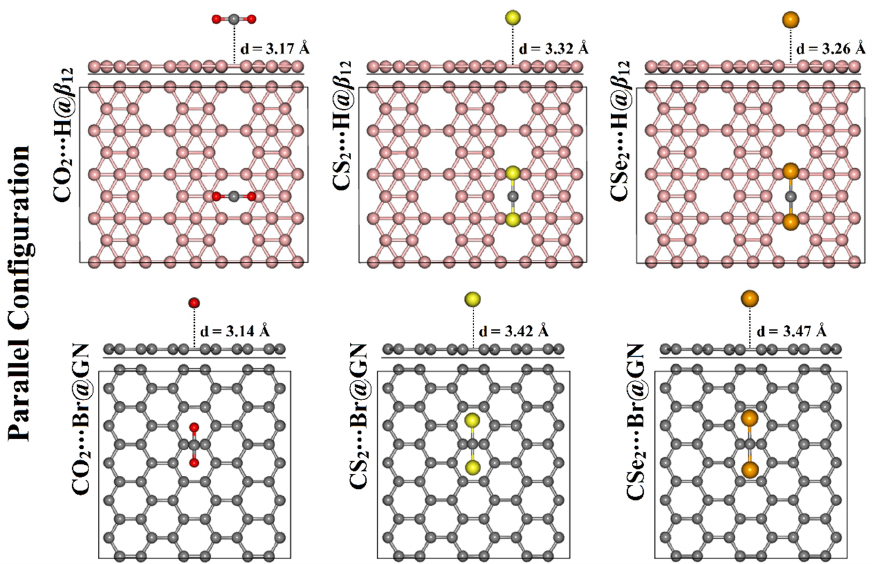
Figure 3. Side and top representations for the relaxed structures of the vertical and parallel configurations of the CX 2 ∙∙∙ β 12 /GN complexes (where X = O, S, or Se) at the most favorable energetic sites. Equilibrium distances (d) are given in Å.